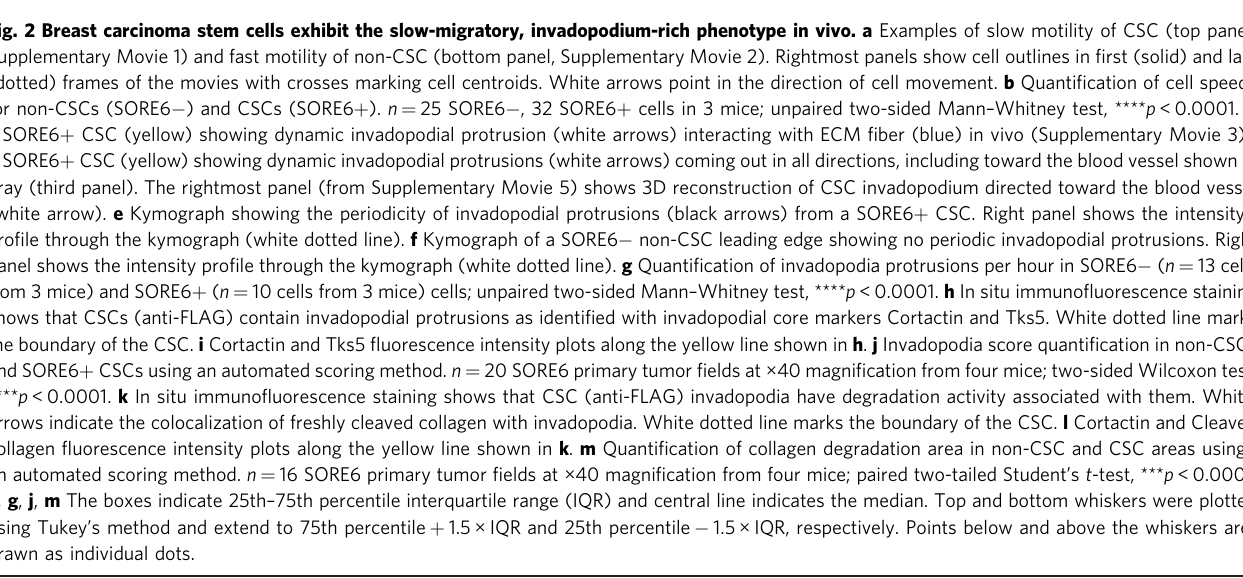
Fig. 2 Breast carcinoma stem cells exhibit the slow-migratory, invadopodium-rich phenotype in vivo. a Examples of slow motility of CSC (top panel, Supplementary Movie 1) and fast motility of non-CSC (bottom panel, Supplementary Movie 2). Rightmost panels show cell outlines in fi rst (solid) and last (dotted) frames of the movies with crosses marking cell centroids. White arrows point in the direction of cell movement. b Quanti fi cation of cell speeds for non-CSCs (SORE6 − ) and CSCs (SORE6 + ). n = 25 SORE6 − , 32 SORE6 + cells in 3 mice; unpaired two-sided Mann – Whitney test, **** p < 0.0001. c SORE6 + CSC (yellow) showing dynamic invadopodial protrusion (white arrows) interacting with ECM fi ber (blue) in vivo (Supplementary Movie 3). d SORE6 + CSC (yellow) showing dynamic invadopodial protrusions (white arrows) coming out in all directions, including toward the blood vessel shown in gray (third panel). The rightmost panel (from Supplementary Movie 5) shows 3D reconstruction of CSC invadopodium directed toward the blood vessel (white arrow). e Kymograph showing the periodicity of invadopodial protrusions (black arrows) from a SORE6 + CSC. Right panel shows the intensity pro fi le through the kymograph (white dotted line). f Kymograph of a SORE6 − non-CSC leading edge showing no periodic invadopodial protrusions. Right panel shows the intensity pro fi le through the kymograph (white dotted line). g Quanti fi cation of invadopodia protrusions per hour in SORE6 − ( n = 13 cells from 3 mice) and SORE6 + ( n = 10 cells from 3 mice) cells; unpaired two-sided Mann – Whitney test, **** p < 0.0001. h In situ immuno fl uorescence staining shows that CSCs (anti-FLAG) contain invadopodial protrusions as identi fi ed with invadopodial core markers Cortactin and Tks5. White dotted line marks the boundary of the CSC. i Cortactin and Tks5 fl uorescence intensity plots along the yellow line shown in h . j Invadopodia score quanti fi cation in non-CSCs and SORE6 + CSCs using an automated scoring method. n = 20 SORE6 primary tumor fi elds at ×40 magni fi cation from four mice; two-sided Wilcoxon test, **** p < 0.0001. k In situ immuno fl uorescence staining shows that CSC (anti-FLAG) invadopodia have degradation activity associated with them. White arrows indicate the colocalization of freshly cleaved collagen with invadopodia. White dotted line marks the boundary of the CSC. l Cortactin and Cleaved collagen fl uorescence intensity plots along the yellow line shown in k . m Quanti fi cation of collagen degradation area in non-CSC and CSC areas using an automated scoring method. n = 16 SORE6 primary tumor fi elds at ×40 magni fi cation from four mice; paired two-tailed Student ’ s t -test, *** p < 0.0001. b , g , j , m The boxes indicate 25th – 75th percentile interquartile range (IQR) and central line indicates the median. Top and bottom whiskers were plotted using Tukey ’ s method and extend to 75th percentile + 1.5 × IQR and 25th percentile − 1.5 × IQR, respectively. Points below and above the whiskers are drawn as individual